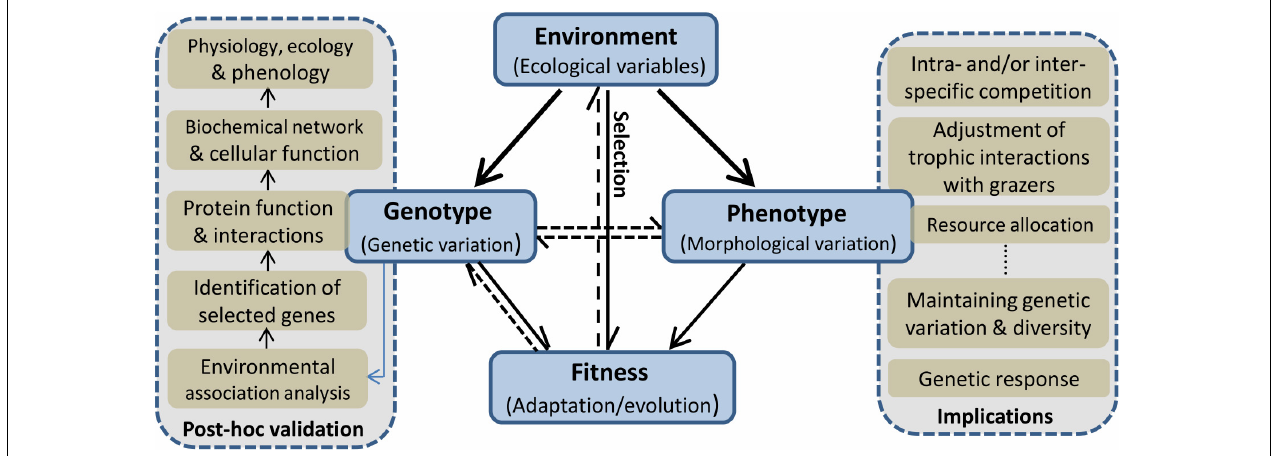
FIGURE 1 | A simplified diagram showing the interactive relationships among environment, phenotype, and genotype, which ultimately impact fitness. The identified genotypes linked to specific adaptation can be validated in a post hoc process, including the initial association analysis with the selected environmental variables, identification of the target genes under selective pressure, and subsequently protein function and interactive network with other molecules, and finally functional identification at a tissue level. At the same time, the evolved plastic phenotypes have wide ecological implications, such as the overwhelming competition to the rival, the adjustment of community balance, and resource allocation under a harsh environment. Solid lines indicate the main research fields connecting one to another in macrophytes, and dashed lines indicate the research gaps that need to be focused on in the